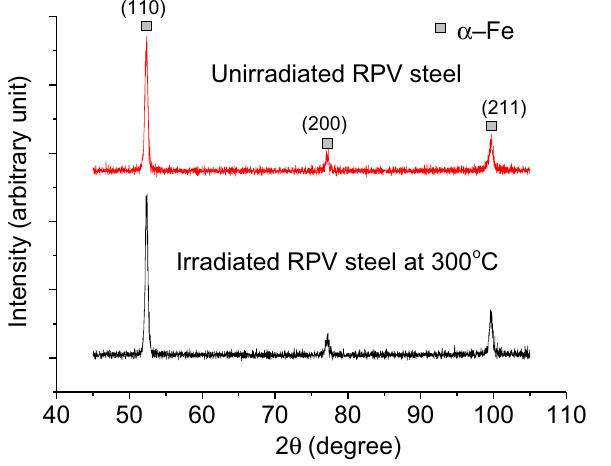
Figure 1. GIXRD diffractogram of unirradiated RPV steel sample and sample irradiated to 0.2 dpa at 573 K obtained at glazing angle of 2.5°.